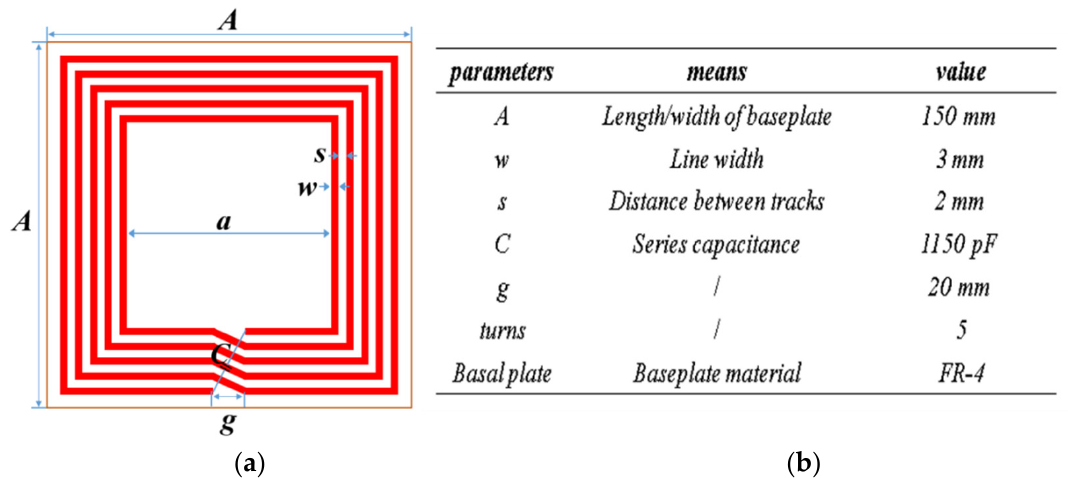
Figure 5. Schematic diagram and parameters of NMM structural units: ( a ) size structure diagram of the material, and ( b ) the meaning and actual size of the NMM in ( a ).